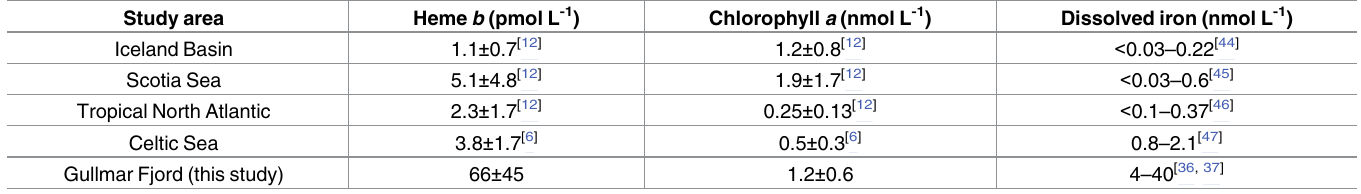
Table 2. Comparison of heme b , chlorophyll a and dissolved iron values observed in the Gullmar Fjord (this study) with other studies from the Atlantic Ocean. Study area Heme b (pmol L -1 ) Chlorophyll a (nmol L -1 ) Dissolved iron (nmol L -1 ) Iceland Basin Scotia Sea Tropical North Atlantic Celtic Sea Gullmar Fjord (this